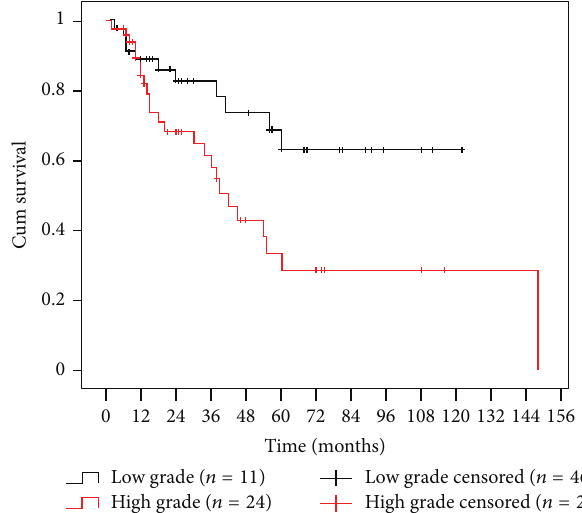
Figure 1: Kaplan-Meier analysis plotting disease-free survival according to the WHO grading of dysplasia ( 𝑃 = 0.006 , Log-rank test).